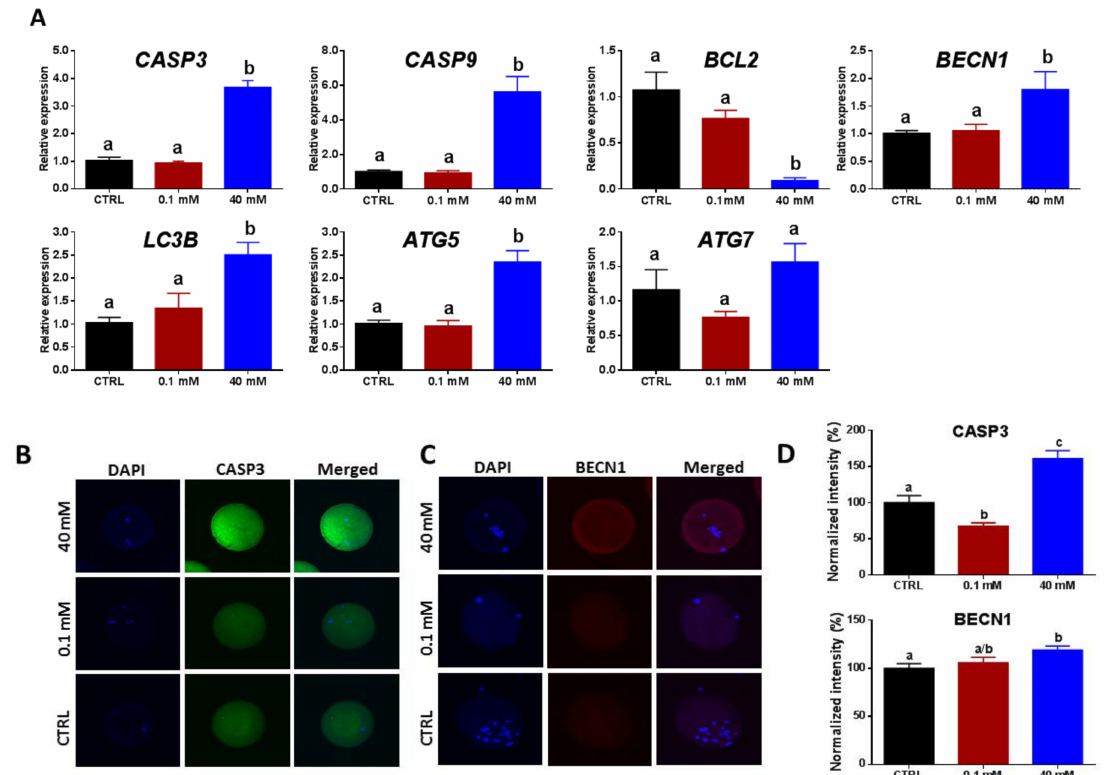
Figure 5. E ff ect of NAM addition during the maturation of oocytes on the levels of apoptosis and autophagy. ( A ) Relative expression of mRNA of di ff erent apoptosis- and autophagy-related genes. Immunofluorescence of CASP3 ( B ) and BECN1 ( C ) in oocytes treated with 0.1 and 40 mM NAM. ( D ) Integrated fluorescence intensities of CASP3 and BECN1 in oocytes. Original magnification 100 × . Superscripts with di ff erent letters indicate statistical